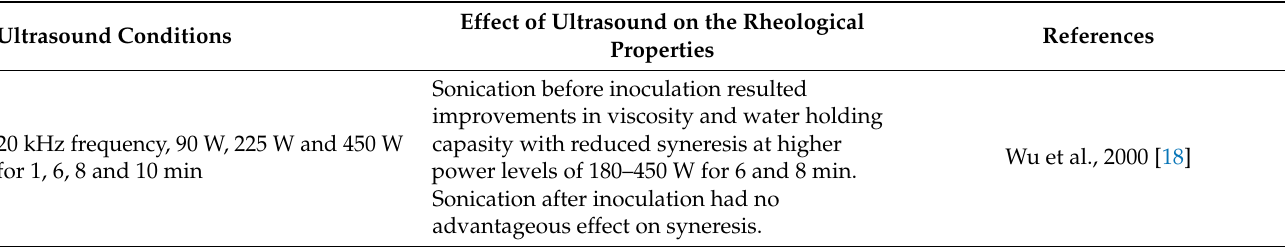
Table 1. The effect of ultrasound on the rheological properties of yoghurt gels. Ultrasound